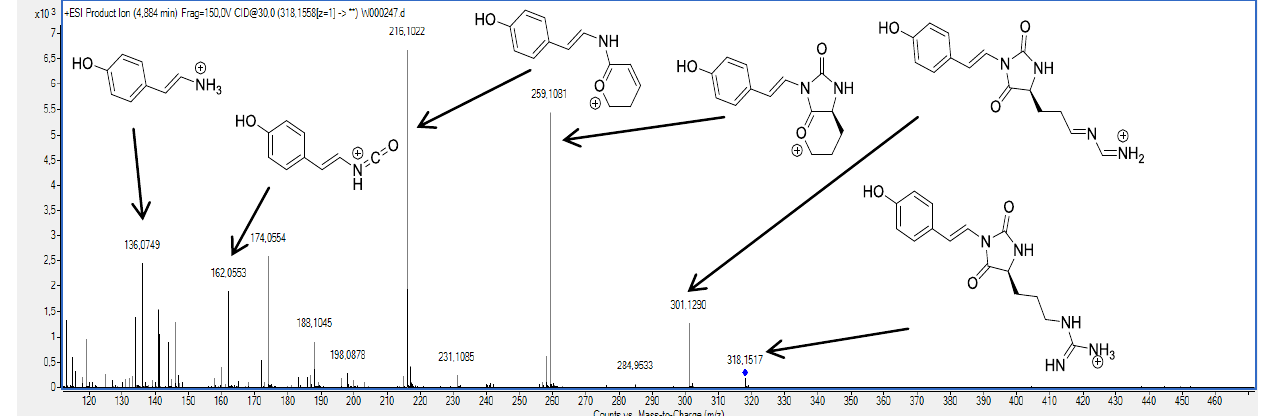
Figure 3. Fragmentation pattern of the parazoanthine A using a 20 V collision energy on the pseudo-molecular ion at m / z